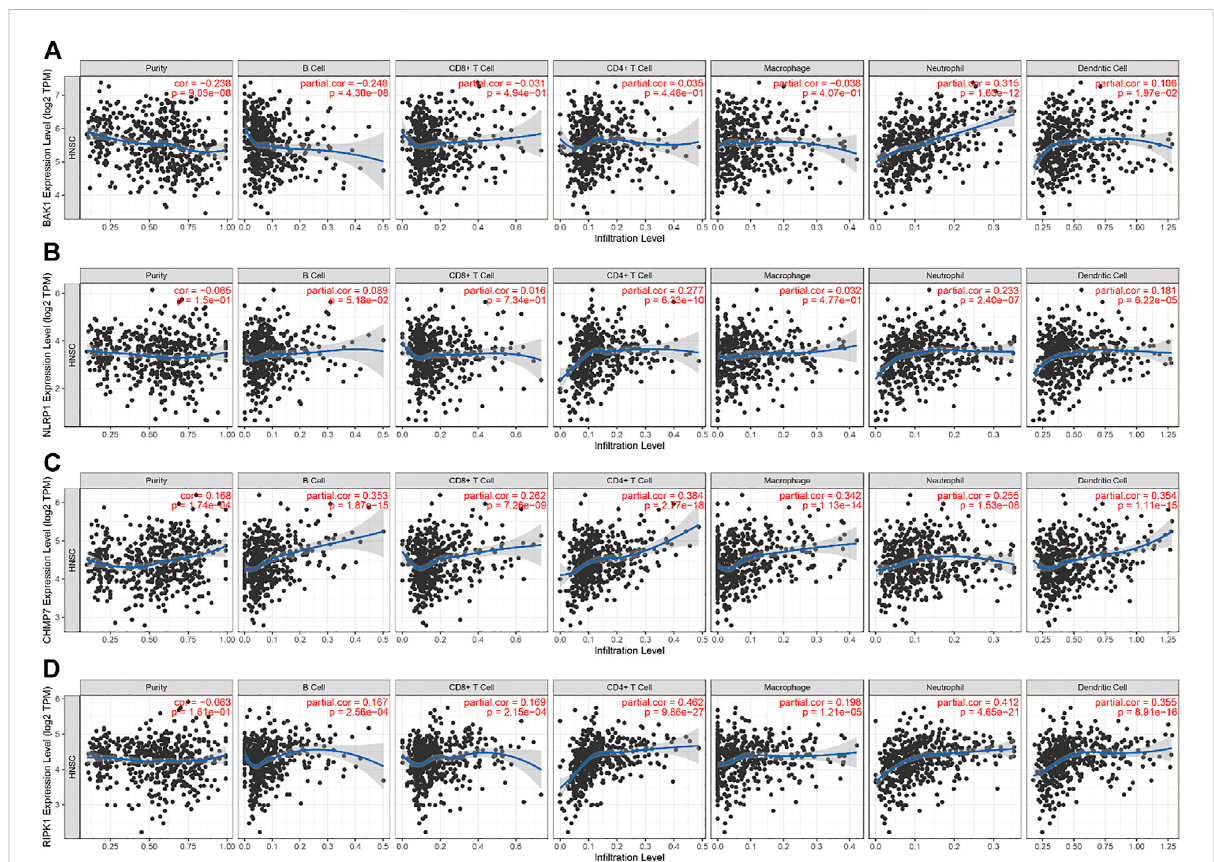
FIGURE 11 Correlation between BAK1 , NLRP1 , CHMP7 , and RIPK1 genes ’ expression and immune in fi ltration. (A) Correlation between BAK1 expression levels and B cell, CD8 + T cell, CD4 + T cell, macrophage, neutrophil, dendritic cell (DC) in fi ltration; (B) Correlation between NLRP1 expression levels and B cells, CD8 + T cells, CD4 + T cells, macrophages, neutrophils, and DC in fi ltration; (C) Correlation between CHMP7 expression levels and